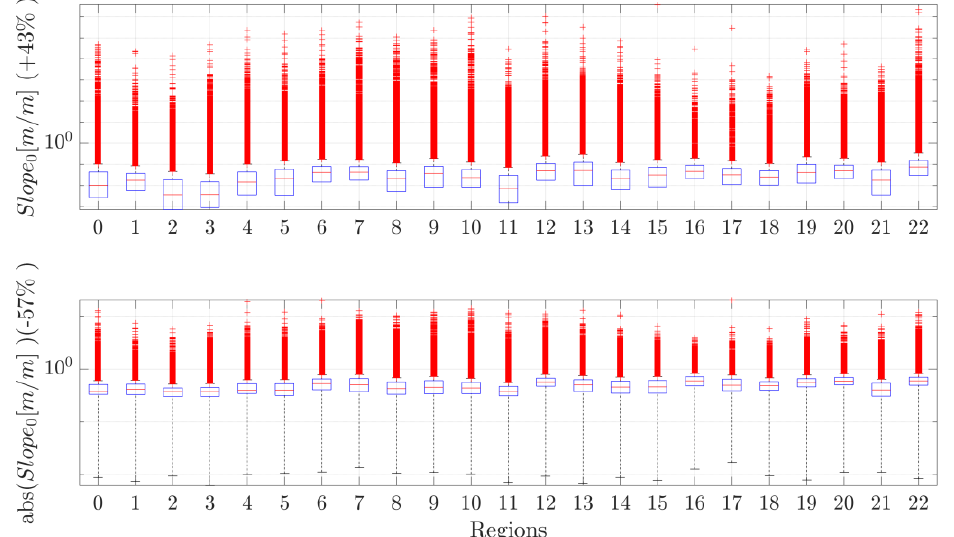
Figure 16. Regional statistics of initial backshore slope S 0 along GB coastline. The central mark indicates the median, and the bottom and top edges of the box indicate the 25th and 75th percentiles, respectively. The whiskers extend to the most extreme data points not considered outliers, and the outliers are plotted individually using the “+” symbol. To obtain these stats, we did not include clusters that corresponded with non-cliff coastlines (Clusters 1, 5 and 8) and 4% of other clusters that had 𝐻 𝑐,0 < 0 . See Table S1 for correspondence between region number and admin unit used.